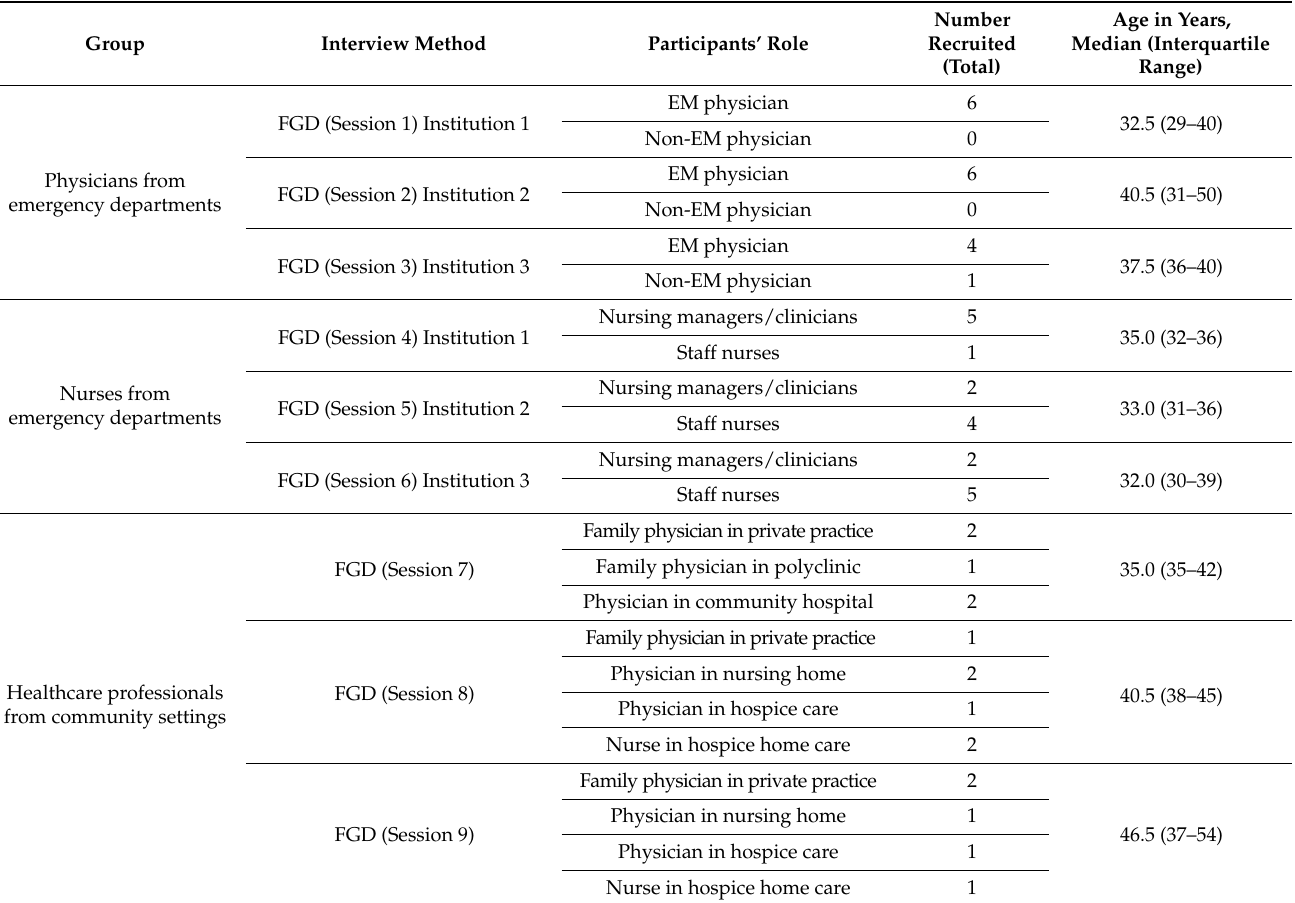
Table 1. Participants’ demographic